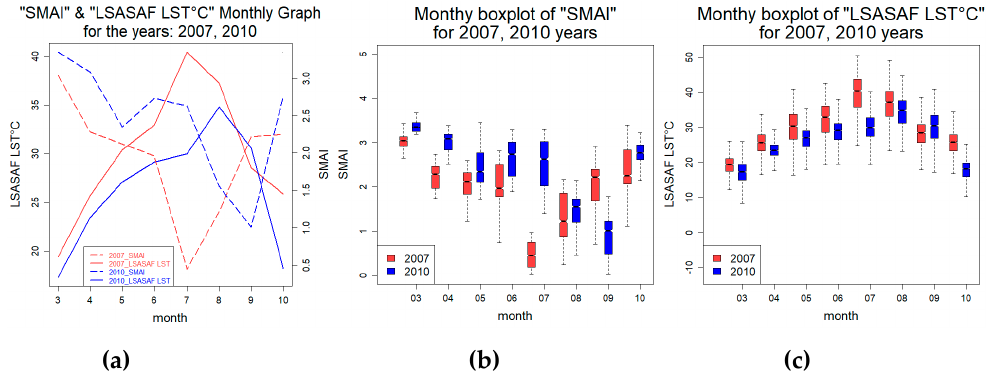
Figure 2. Monthly mean (March–October) course of biogeophysical indices for a selected ‘dry 2007 (in red)’ and a ‘wet 2010 (in blue)’ year: ( a ) SMAI (dotted line) indicating drought severity and LST 0900 UTC (solid line); Comparing datasets: ( b ) SMAI boxplots with notches; ( c ) Land Surface Analysis Satellite Application Facility (LSASAF) LST 0900 UTC boxplots with notches.